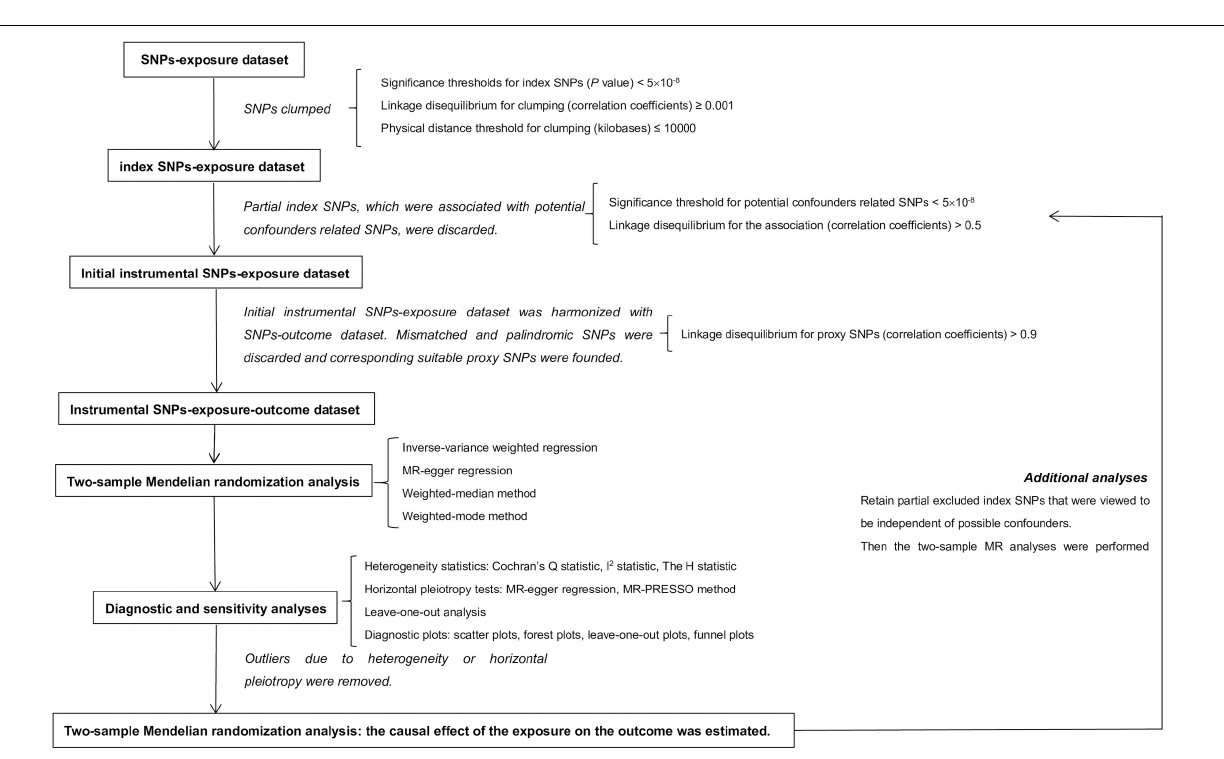
Bonferroni-corrected P < 5 × 10 − 8 ) and IVs should be